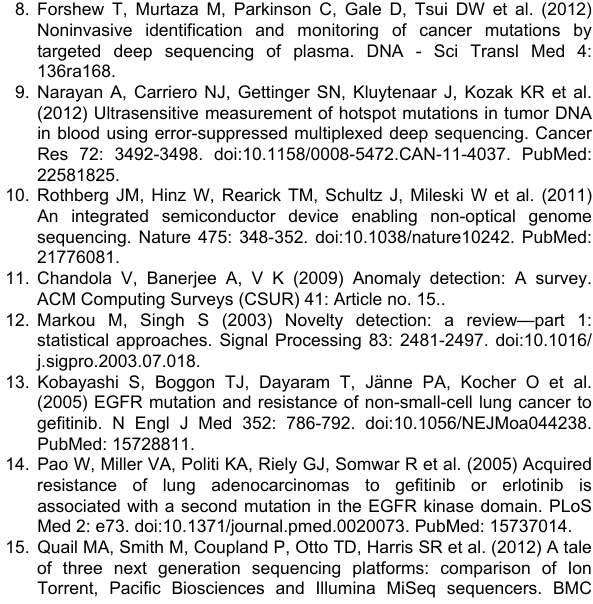
File S1. Figure S1. Relationship between the averages and variances of the insertion/deletion errors. Figure S2. Outline of the method. Figure S3. Dynamics of mutant alleles in plasma cell-free DNA during EGFR-TKI treatment.